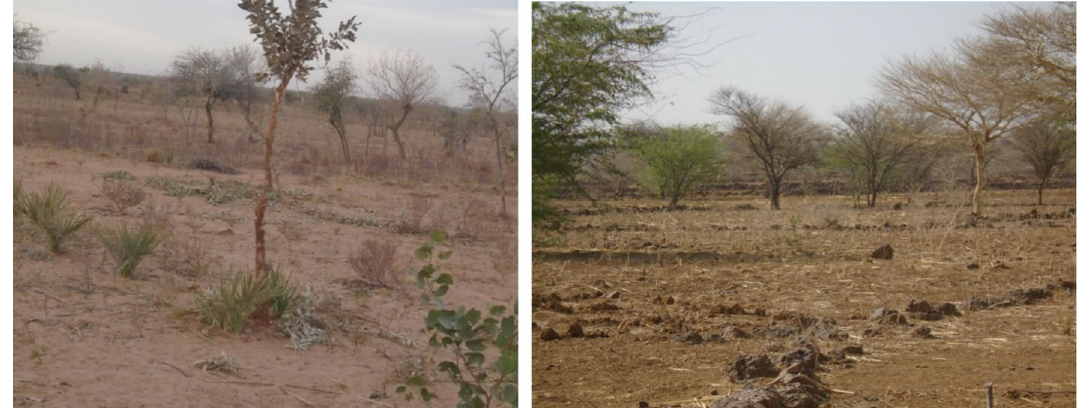
Picture 1 On the left: plot with Assisted Tree Regeneration practice. On the right: plot with stony lines coupled with tree planted